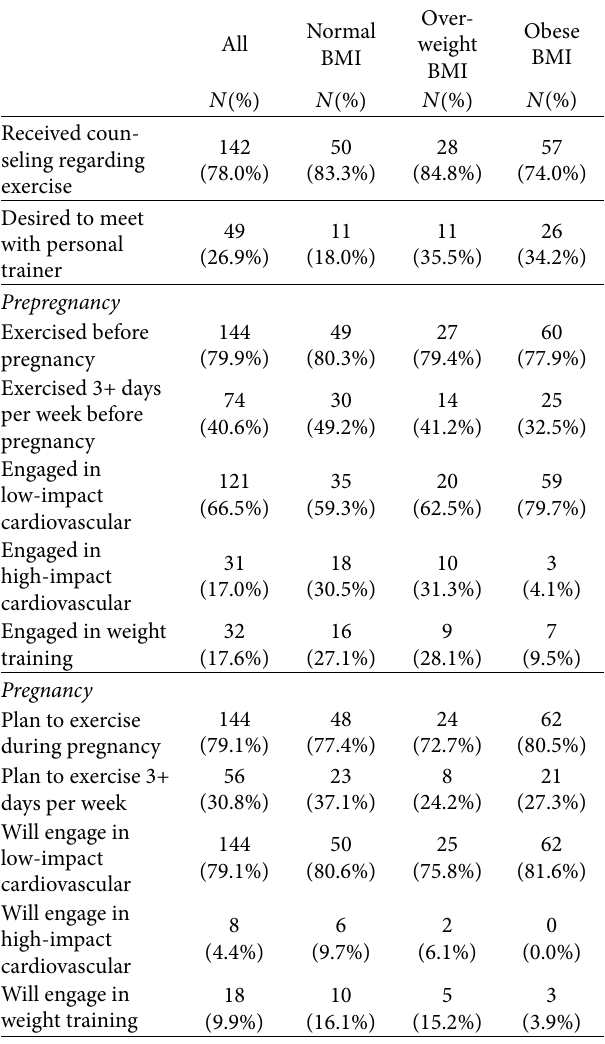
Table 2: Counseling and patient exercise habits prepregnancy and during pregnancy by